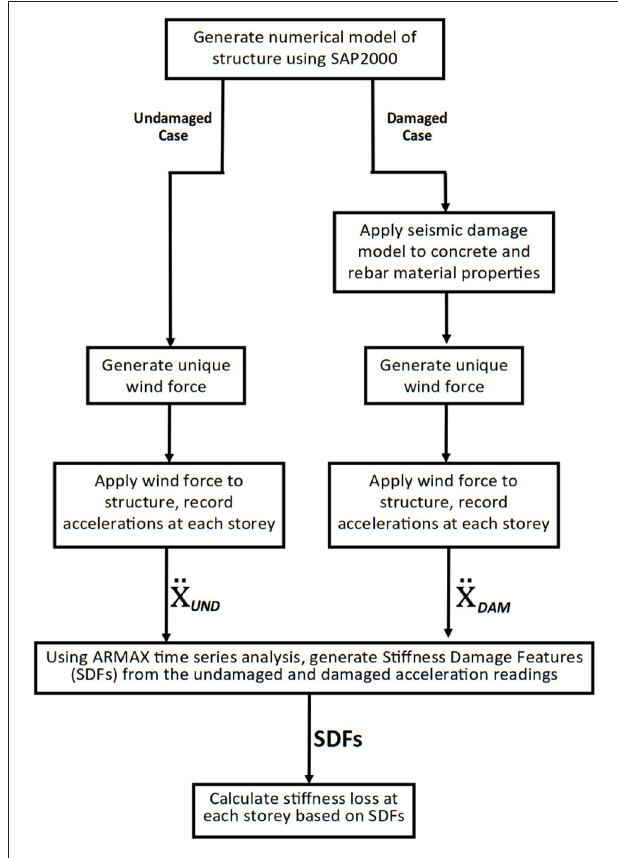
FIGURE 1 | Damage model